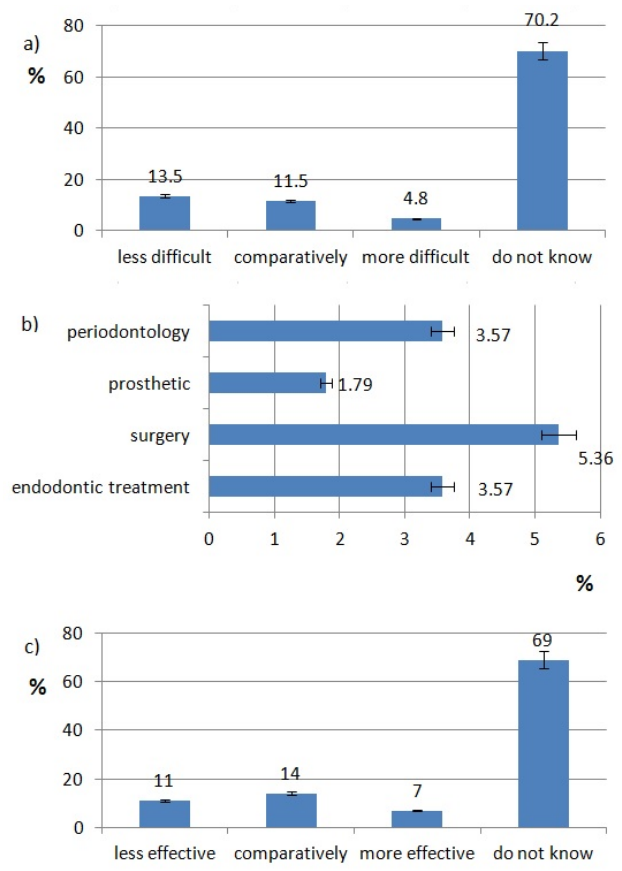
Figure 5. Ozone use pattern of responding dentists; ( a ) effectiveness of ozone procedures, ( b ) type of ozone procedures, ( c ) difficulty of ozone procedures.